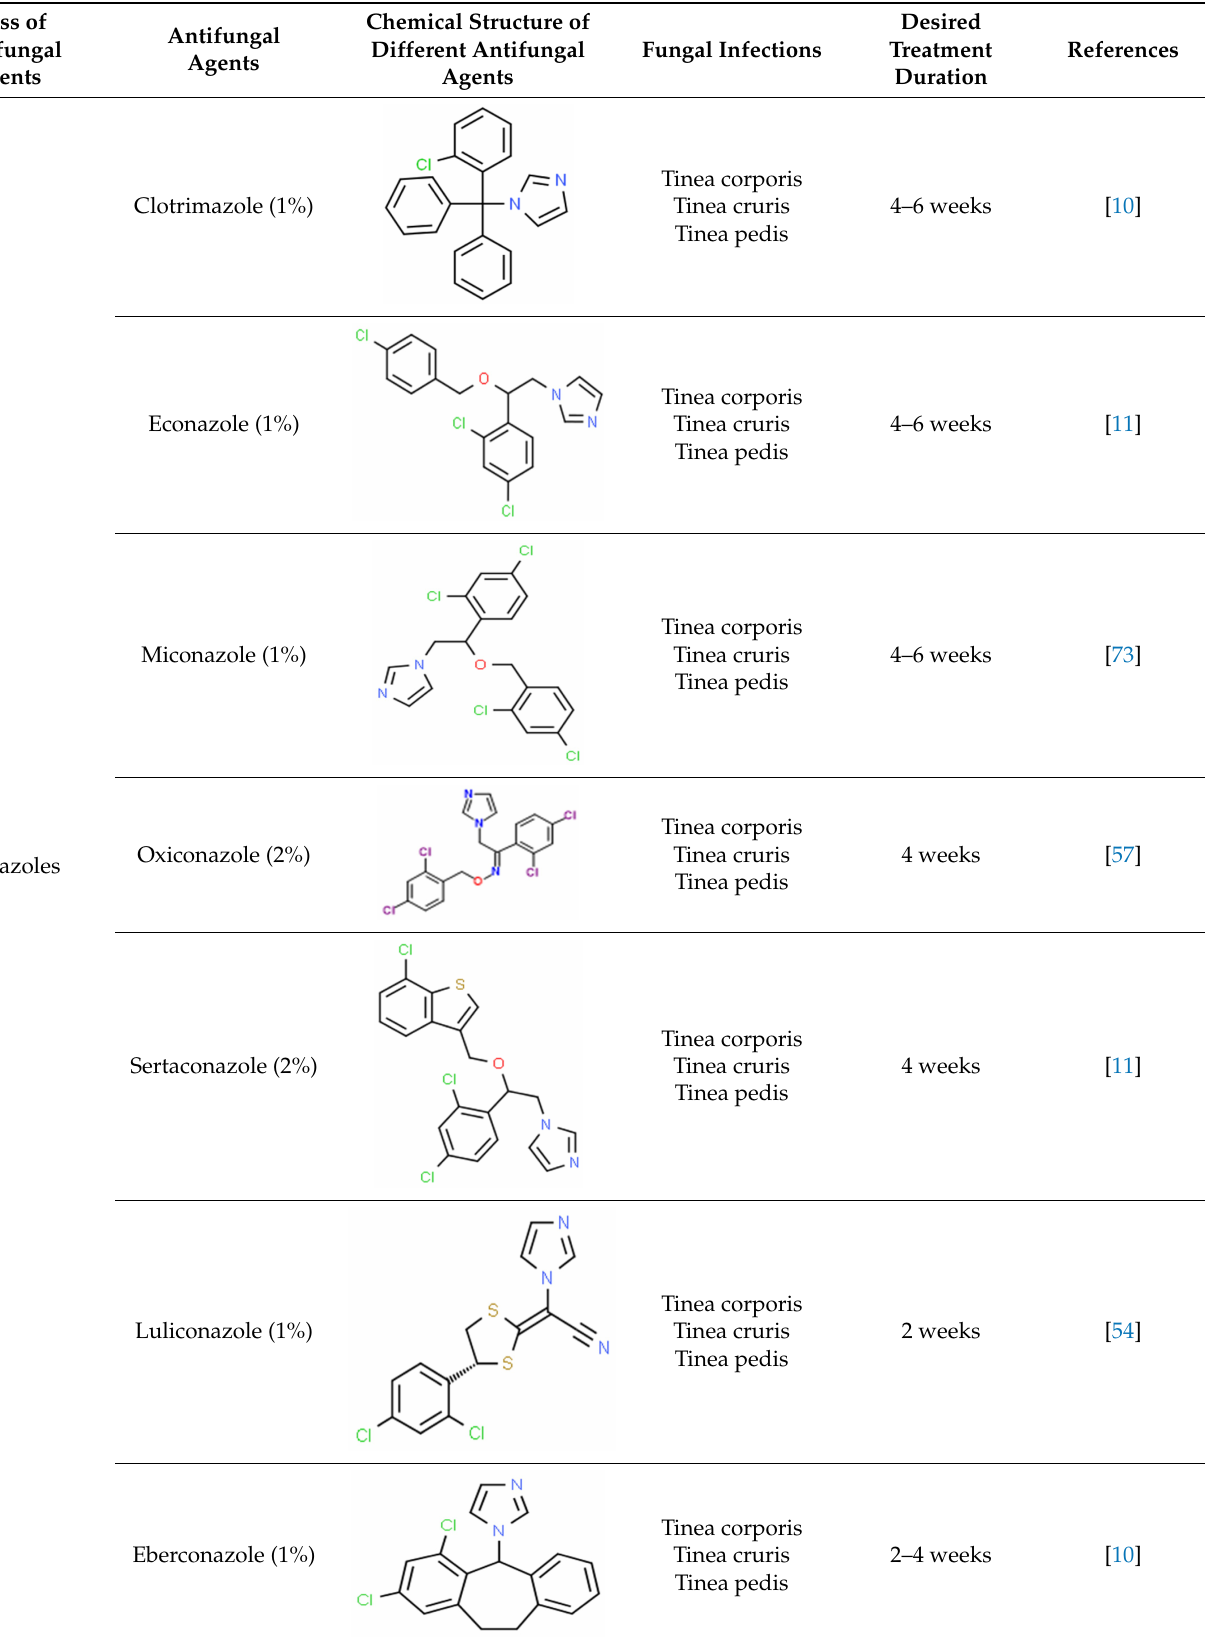
Table 4. Classification of antifungal components and their effectiveness against various fungal